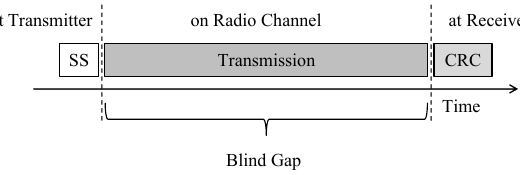
Figure 1. Limited spectrum awareness during